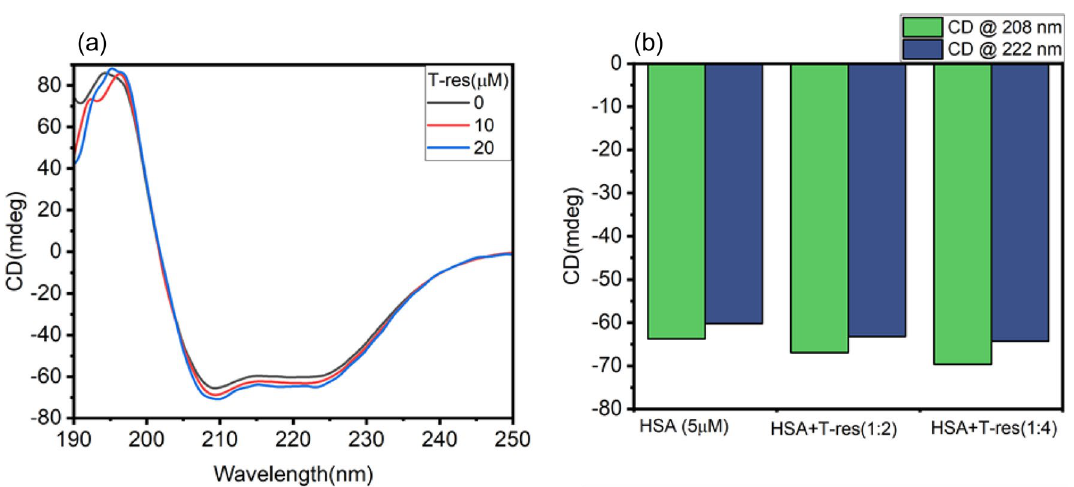
Figure 5. (a) Far UV-CD spectra of HSA (5 µM) in the presence of a different concentration of trans - resveratrol with HSA (10 µM and 20 µM) at 298.15 K and pH 7.4. (b) Bar graph showing the CD values in mdeg, at 280 and 222 nm, for HSA alone and HSA in the presence of different molar ratio of trans- resveratrol (1:2 and